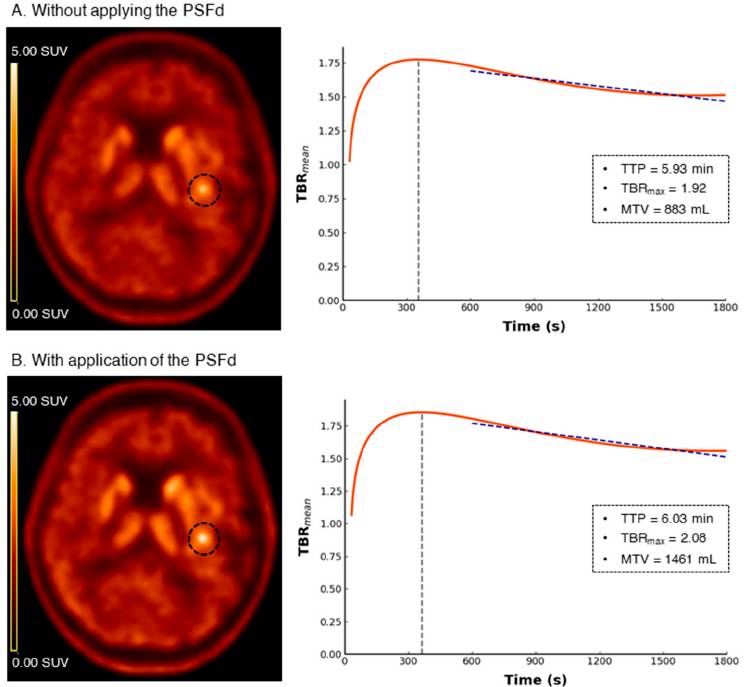
Figure 1. Representative 18 F-FDOPA PET images for without applying the PSFd ( A ) and with application of the PSFd ( B ) alongside the related region-based time-activity-curve ratios (TAC ratio ). Tumor volumes of interest are demonstrated on PET images with dashed circles. Application of the PSFd increases the contrast in tumor uptake, but effects on the TAC ratio , and consequently effects on TTP, obtained from the region-based analysis are limited. Patient characteristics: 75-year-old female patient classified as an IDH-wildtype glioblastoma. PSFd: point spread function deconvolution; TTP: time-to-peak; SUV: standardized uptake value; TBR mean : mean of tumor-to-background-ratio; Cancers 2022 , 14 , x FOR PEER REVIEW TBR max : maximum of tumor-to-background-ratio; MTV: metabolic tumor volume.